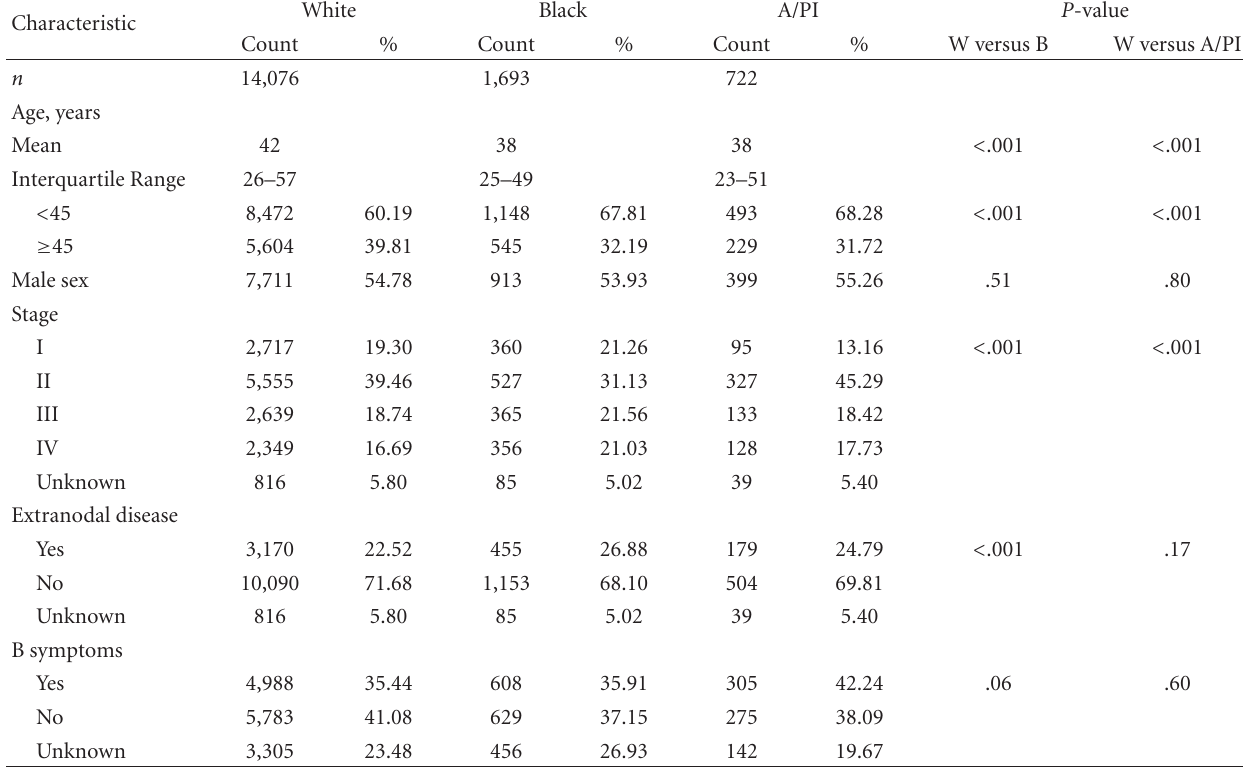
Table 2: Racial di ff erences in the presentation of Hodgkin